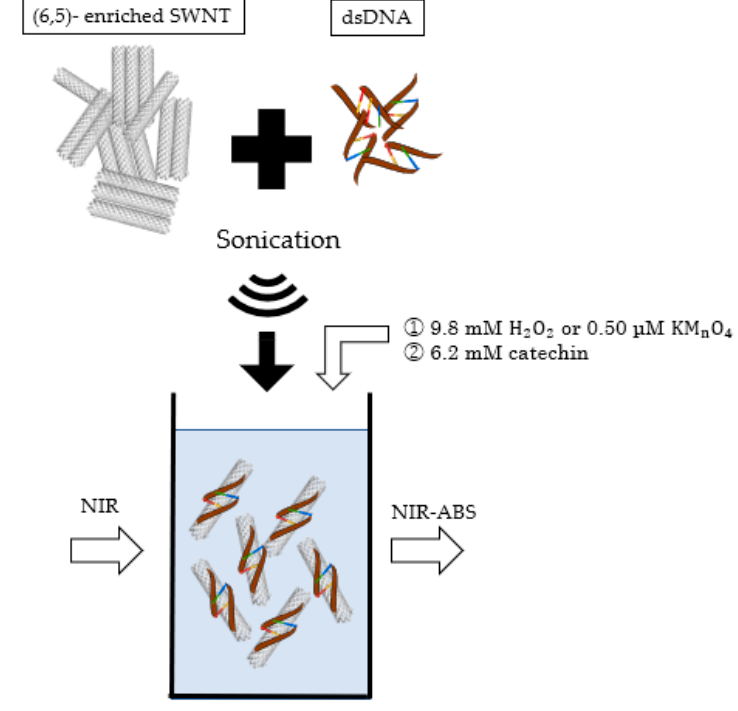
Figure 1. A conceptual diagram of the experiment. The final concentrations of H 2 O 2 and KMnO 4 were 9.8 mM and 0.50 µM, respectively, for NIR-ABS. The final catechin concentration was 6.2 mM. SWNT: single-walled carbon nanotube; NIR: near-infrared; ABS: Absorbance.